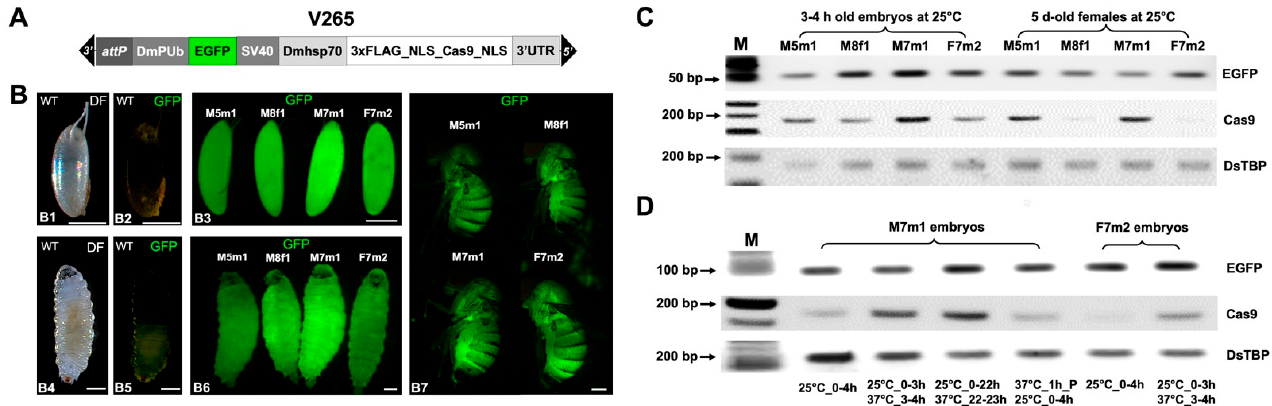
Figure 1. Phenotypical and molecular characterization of the D. suzukii Cas9-expressing lines. ( A ) Schematic map of the piggyBac germline transformation vector V265 (not to scale). The enhanced green fluorescence protein ( EGFP ) marker is regulated by D. melanogaster polyubiquitin promoter ( DmPUb ) and the SV40 polyA. The Cas9 gene with a 3xFLAG protein tag and nuclear localization signals (NLS) is regulated by the D. melanogaster heat shock protein 70 gene promoter ( Dmhsp70 ) and its 3’UTR. V265 also contains an attP recombination site. ( B ) The dark field (DF) or enhanced green fluorescence (GFP) images of 3–4 h (h) wild type (WT) or transgenic embryos (B1–B3), WT or the transgenic third instar larvae (B4–B6), and five days (d) old transgenic females are showed. Transgenic flies were from four independent V265 homozygous lines (M5m1, M8f1, M7m1, and F2f2). Filter sets depicted in the images are described in the Method section. Scale bar: 0.2 mm for B1–B3, 0.5 mm for B4–B7. ( C ) Reverse transcriptase (RT)-PCR was used to compare RNA levels of EGFP , Cas9 , and the housekeeping gene DsTBP from embryos (3–4 h old) and adult females (5 d old) at 25 ◦ C for all four strains. PCR product sizes from the target genes are 79 bp for EGFP , 175 bp for Cas9 , and 182 bp for DsTBP . ( D ) RT-PCR to compare the Cas9 expression at different heat-shock conditions. RNA was extracted from M7m1 and F7m2 embryos. The temperature and embryonic developmental time window of treatment are depicted; Parental flies (P) were treated at 37 ◦ C for 1 h before egg collection; M: molecular